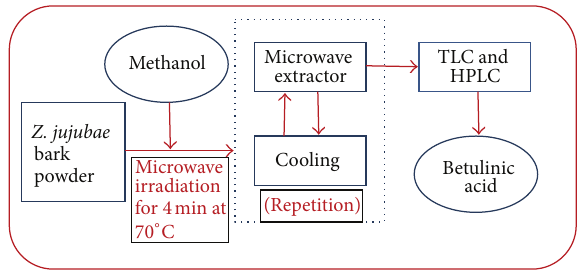
Figure 5: Line diagram for microwave assisted extraction (MAE) method